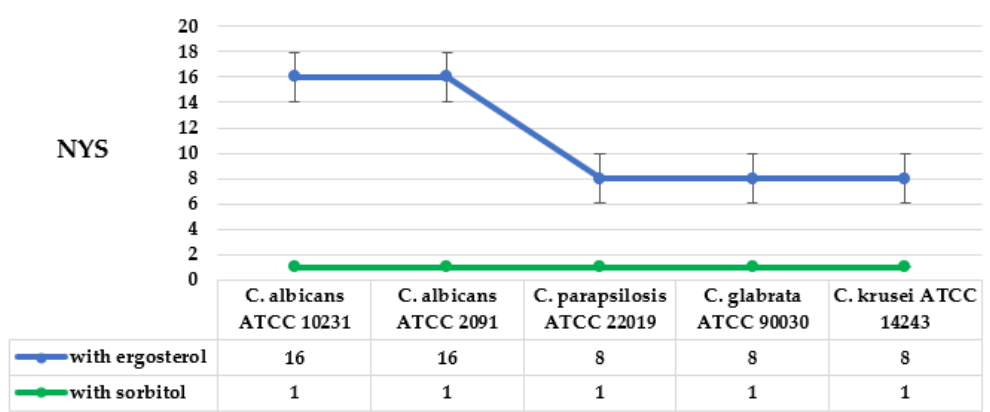
Figure 4. The increase in the MIC values (x MIC) of CEO, EUG and NYS (as control) in the presence of ergosterol (400 μ g/mL) and sorbitol (0.8 M) against reference Candida spp.